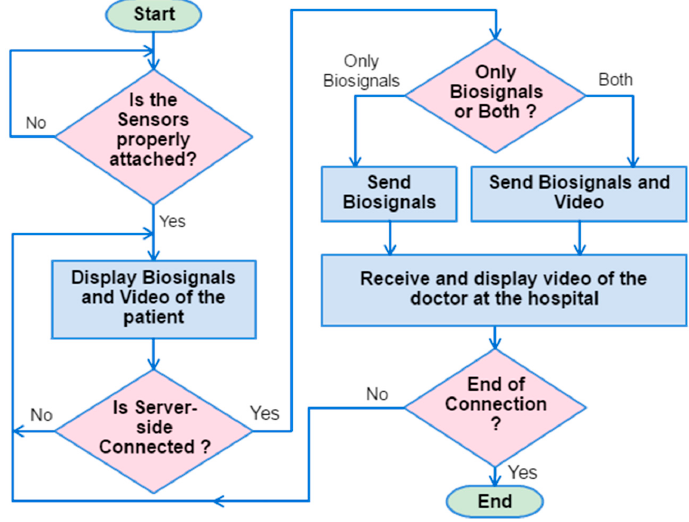
Figure 2. Flowchart of operation for the client tele-diagnosis interface.